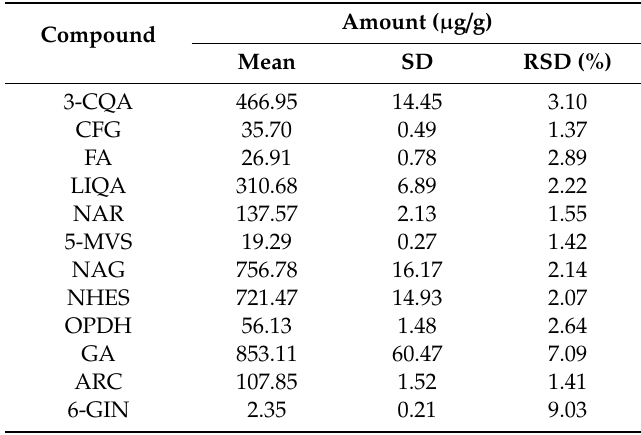
Supplementary Materials: The following are available online at www.mdpi.com/xxx/s1, Figure S1: Chemical structures of 12 biomarker components in YPS, Table S1: Composition of YPS, Table S2: Chromatographic parameters for HPLC analysis of the 12 marker components in YPS, Table S3: MRM parameters for LC–MS/MS analysis of 12 marker components in YPS, Table S4: System suitability of the 12 marker compounds using HPLC– PDA, Table S5: The linear range, regression equation, r 2 , LODs, and LOQs of the analytes from YPS using LC– MS/MS (n = 3).